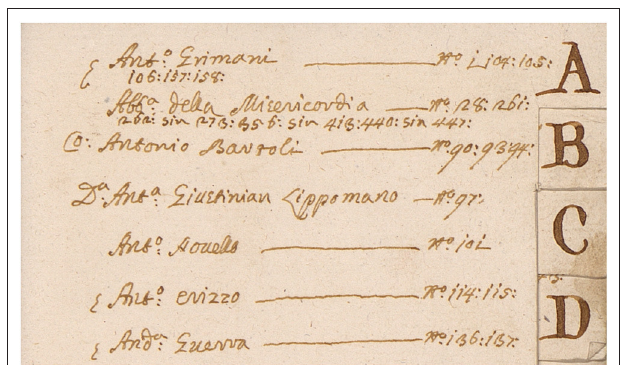
FIGURE 1 | An example of a historical index. There are seven entries organized into lines, each with a mention of a thing (indexation unit, in this case fiscal, or juridical persons) and a list of references (index references). The last entry transcribes as: “Ser Andrea Guerra ... numero 136, 137.”